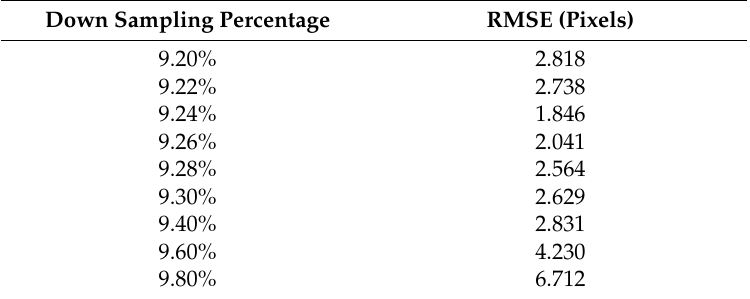
Table 3. RMSE of image registration under 9% down sampling with centesimal